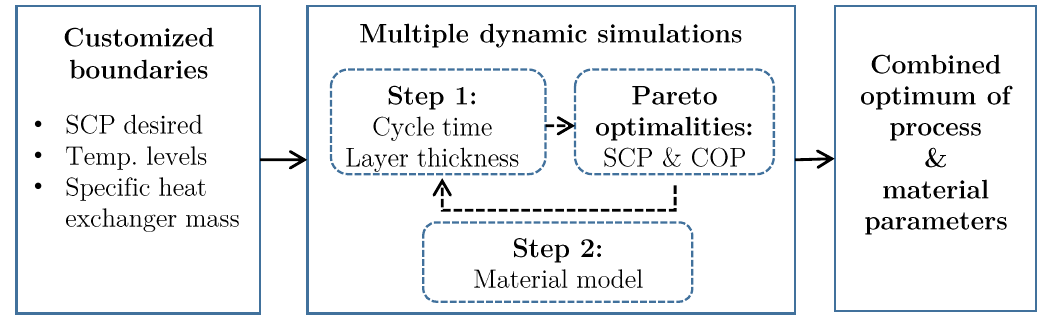
Figure 8. Workflow of two step process and material optimization